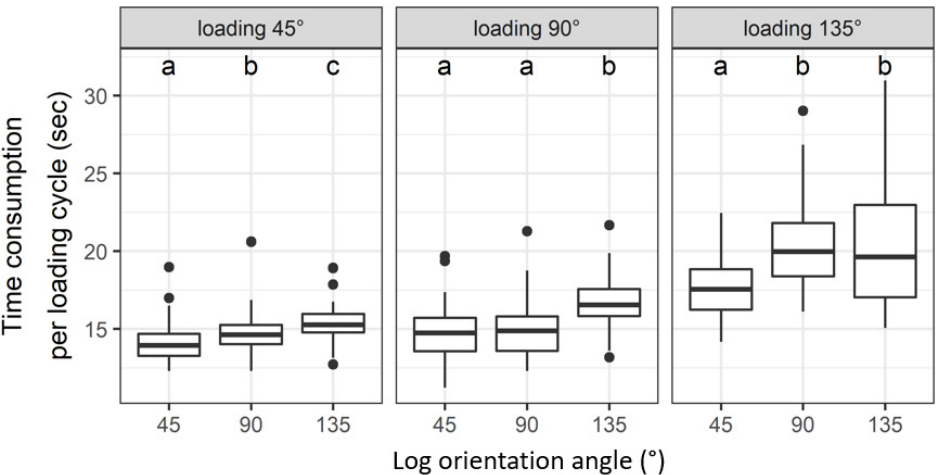
Figure 3. Distribution of time consumption per loading cycle for three log orientation angles and three loading angles.